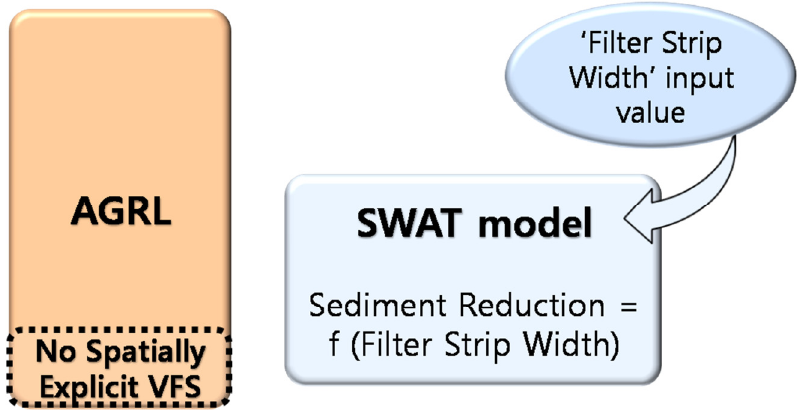
Figure 3. Limitation of the current SWAT for VFS simulation–No spatial location of the VFS in sediment reduction simulation with the VFS. Only filter width is considered for sediment reduction